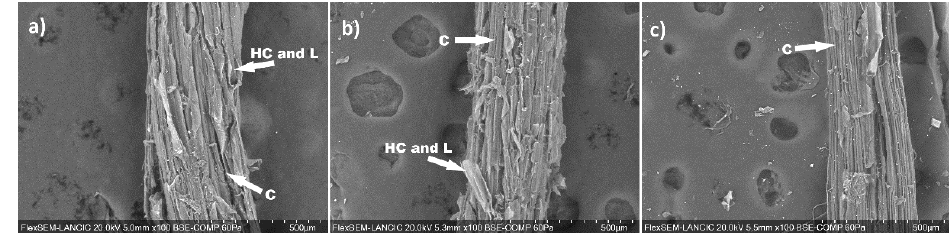
Figure 3. Electron microscopies of the samples of bagasse: ( a ) as obtained (blank), ( b ) at pH 7 after 15 days of degradation, and at ( c ) pH 12 after 30 days of degradation.